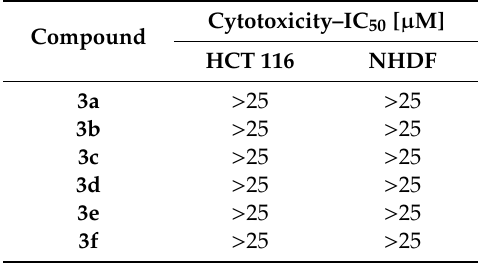
Table 8. Antiproliferative activity on the HCT 116 cell